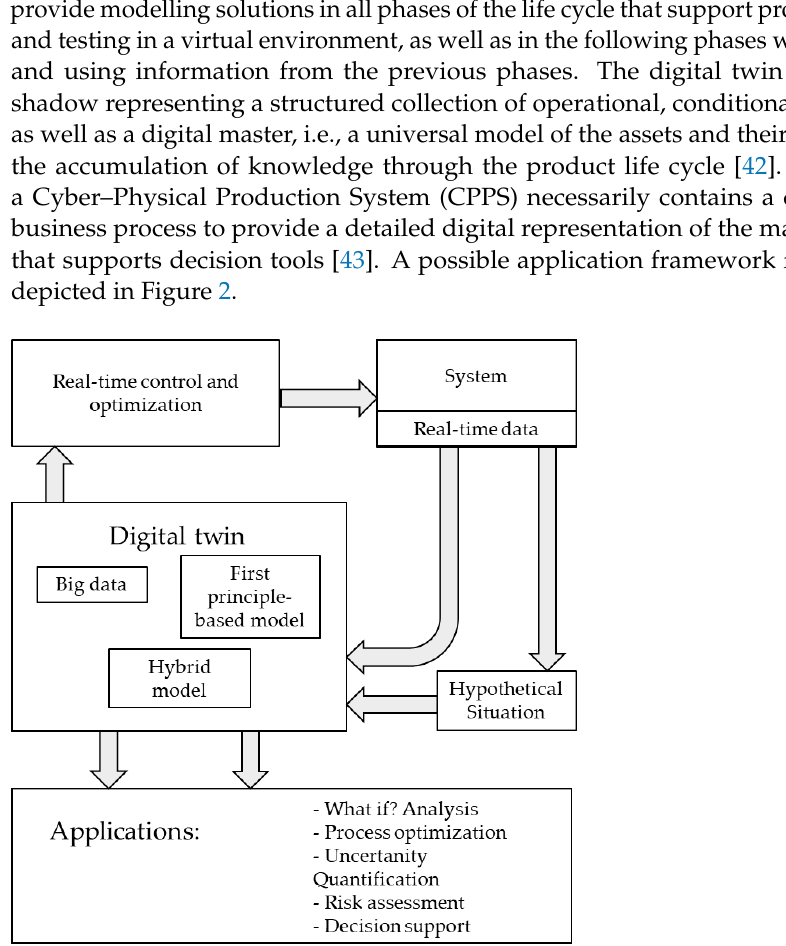
Figure 2. Application framework for digital twins (based on